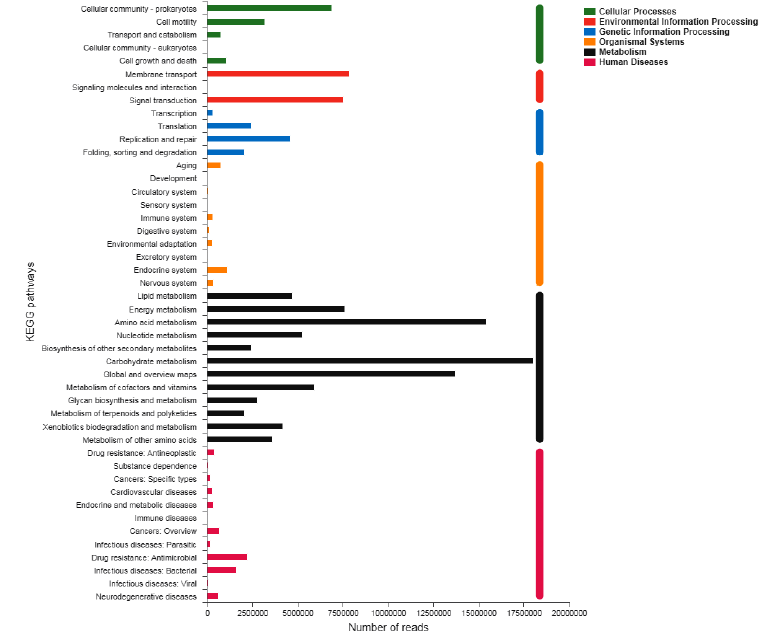
Figure 3. The annotation of the KEGG pathway of